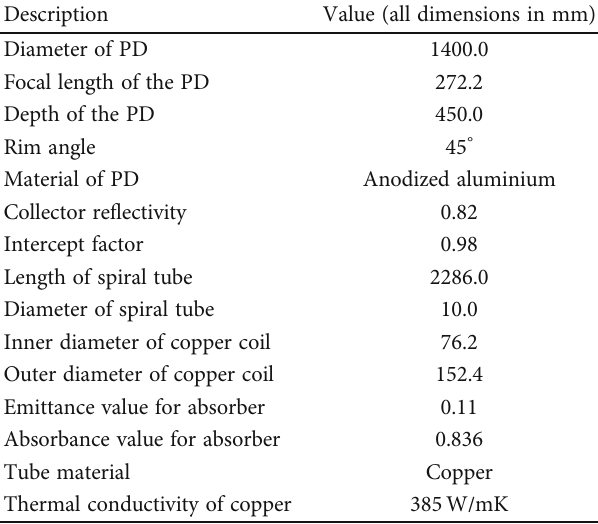
Table 3: Design parameters, material properties, and dimensions of collector and modi fi ed